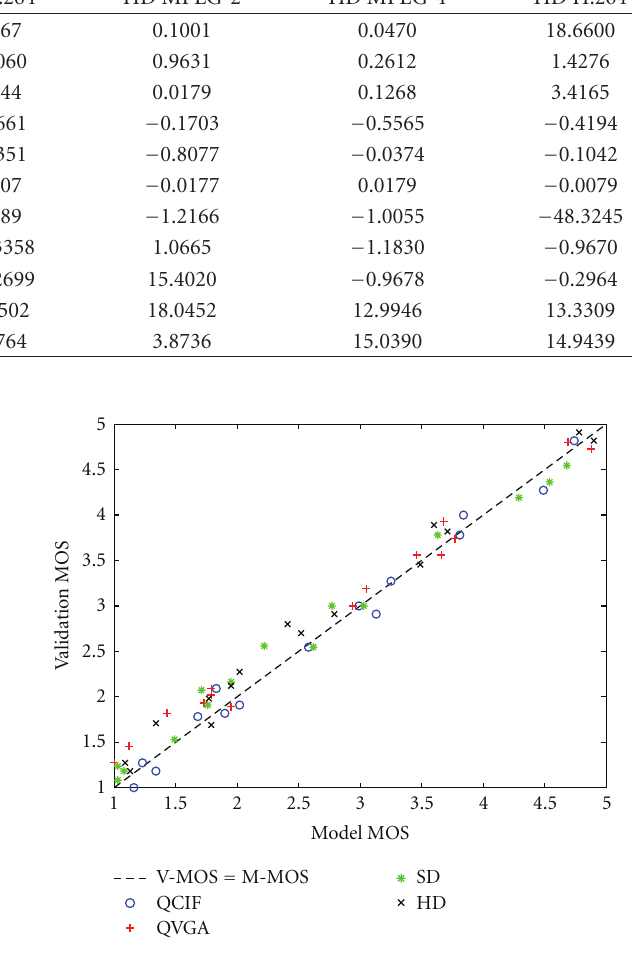
Figure 13: Correlation between TFIFO Model MOS and TFIFO Validation MOS.